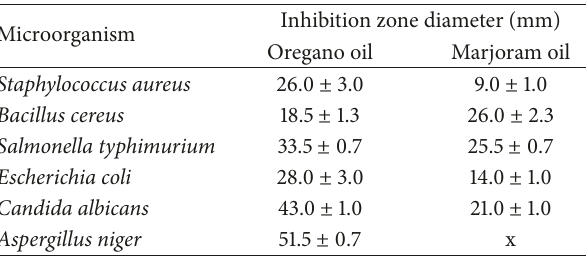
Table 6: Antimicrobial activity of the oregano and marjoram essential oils against selected